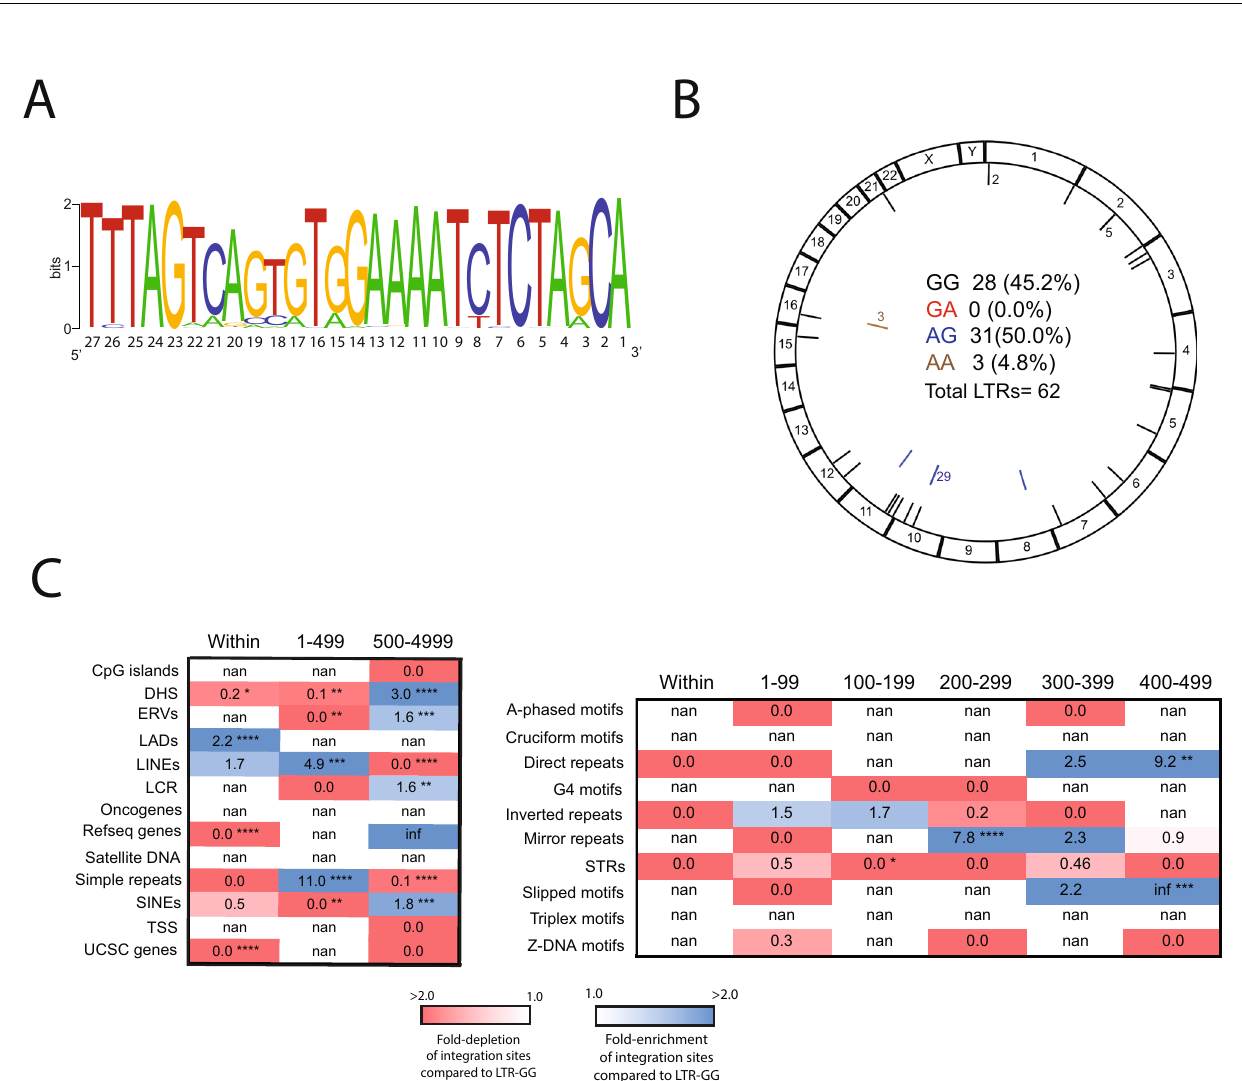
shown inside the circa plots. C Heatmaps depicting the fold-enrichment (blue shading) and depletion (red shading) of integration sites at various distance intervals from common genomic features (left) and non-B DNA features (right). Integration sites from A3F-LTR-GA (top) and A3G-LTR-AG (bottom) proviruses are shown. Fold changes are with respect to A3F-LTR-GG and A3G-LTR-GG, respec- tively. * P <0.05, ** P <0.01, *** P <0.001, **** P <0.0001; Fisher ’ s exact test, two- sided.In fi nitenumber(inf)represents1ormoreintegrationswereobservedwhen0 integrations were expected by chance. Not a number (nan) represents 0 integra- tions were observed and 0 were expected by chance.